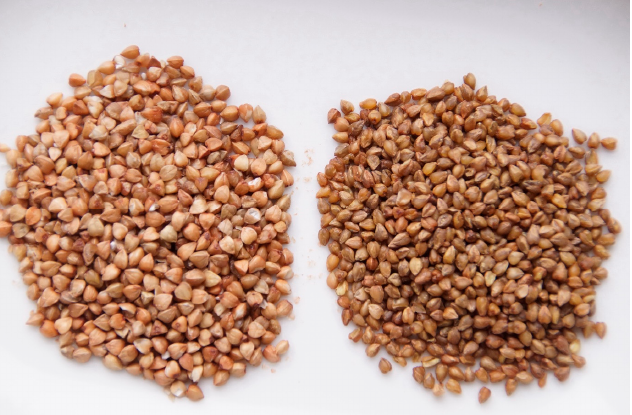
Figure 2. Buckwheat groats obtained using the traditional precooking method: left, common buck- wheat; right, Tartary buckwheat kasha (husked buckwheat grain). For husking, precooked buckwheat grains are firstly soaked in boiling water, and during this treatment, the starch swells. In doing so, the husk bursts on one of the three corners. When ready, the water is removed and the grain is dried at a moderate tempera- ture. In old times, the grain was traditionally dried on canvas in the shade or on a warm top of a wood-burning stove. The grains were repeatedly mixed to dry evenly. They were dried only so that the husk was dry and brittle, and the inside of the grain was elastic, but solid enough not to squeeze or smear when the process continued. Properly dried grain was placed in a husking device called a stope. A stope consists of a stable hollowed trunk with an opening for at least five liters of grain. Above the opening is a fixed beam with a downward-facing iron tip with horizontal ribs. The beam went up several tens of inches and then fell freely into the prepared grain. This was repeated as needed, even a hundred times if necessary. When the grains were struck, the husk was separated from the grain, and groats (kasha) were formed. When most grains were husked, farmers used ventilation to separate light husks from heavier kasha grains. In areas rich in streams, the stopes were powered by water wheels. Stopes were foot-powered in plain landscapes. In Carinthia, Austria, hydrothermally pretreated buckwheat was husked by treading on grain with heavy wooden shoes [16]. Preparing husked buckwheat grain, kasha, is very challenging. The process has been known among Slovenians for a long time, as was described by Val- vasor [17]. The modern husking of buckwheat grain is essentially the same as it used to be— cooking, drying, husking, drying again, and blowing off the husks. The details of technol- ogy are the intellectual property of each producer, especially in husking technology for Tartary buckwheat, which is because of the significant issue of thick husks. To separate